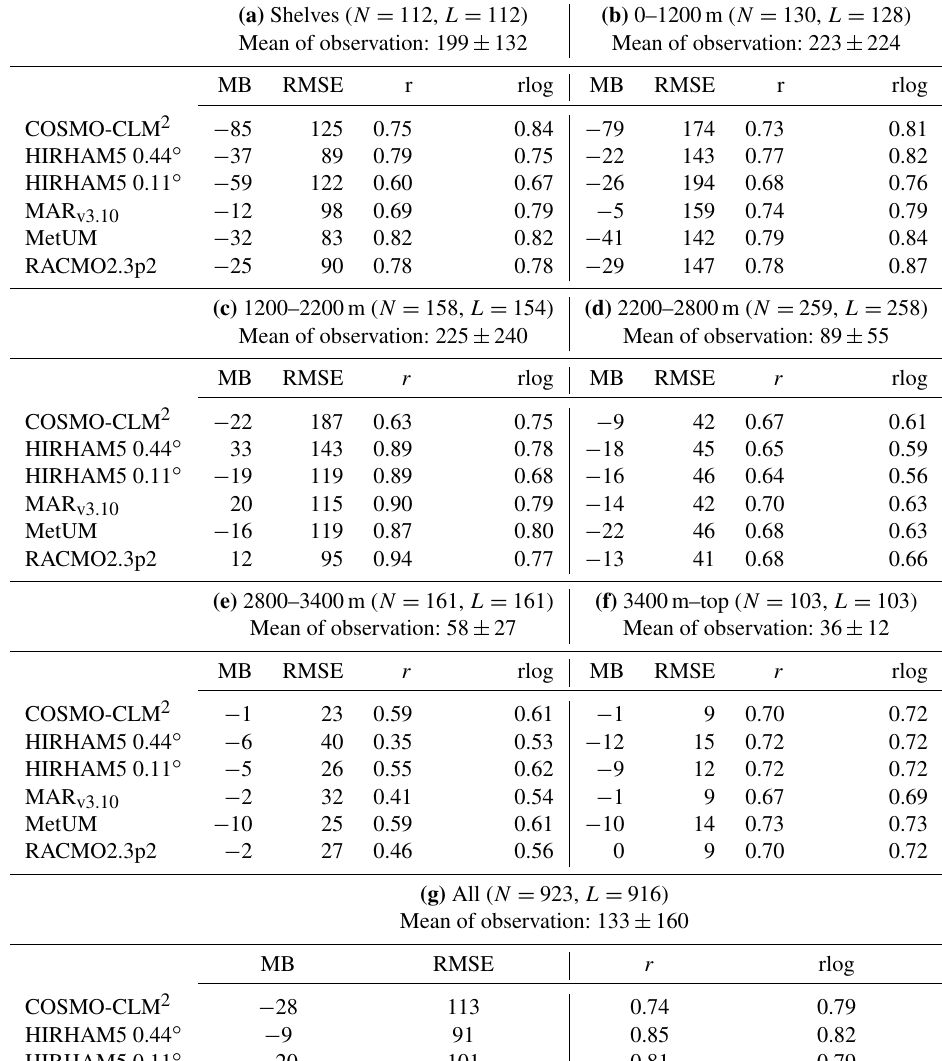
Table 2. Comparison of the modelled SMB to the SMB observations over the ice shelves (a) , by elevation bins (b–f) , and over the whole AIS (g) . Unit of mean bias (MB), root mean square error (RMSE), and mean of the observation is kgm − 2 yr − 2 . N denotes the number of comparison used for each bin, while L represents the number of comparisons that used the log